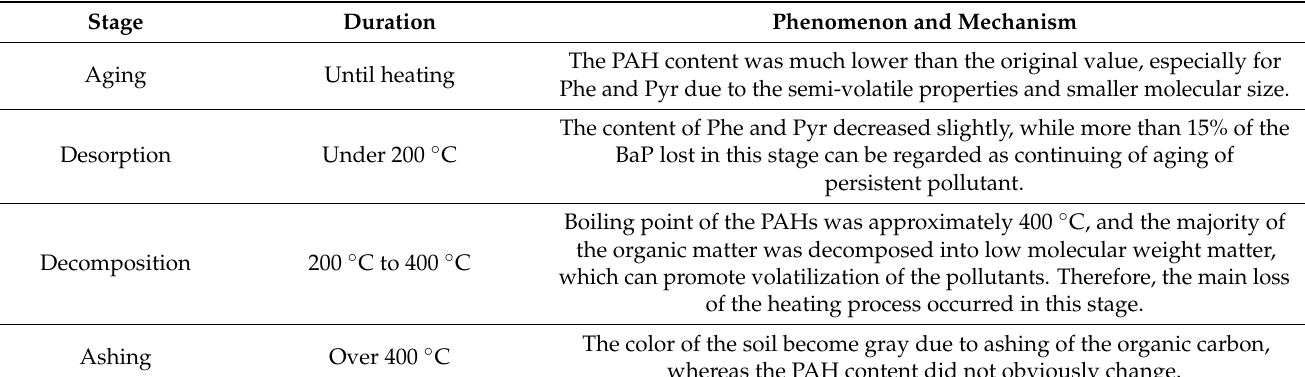
Table 4. Four steps of thermal